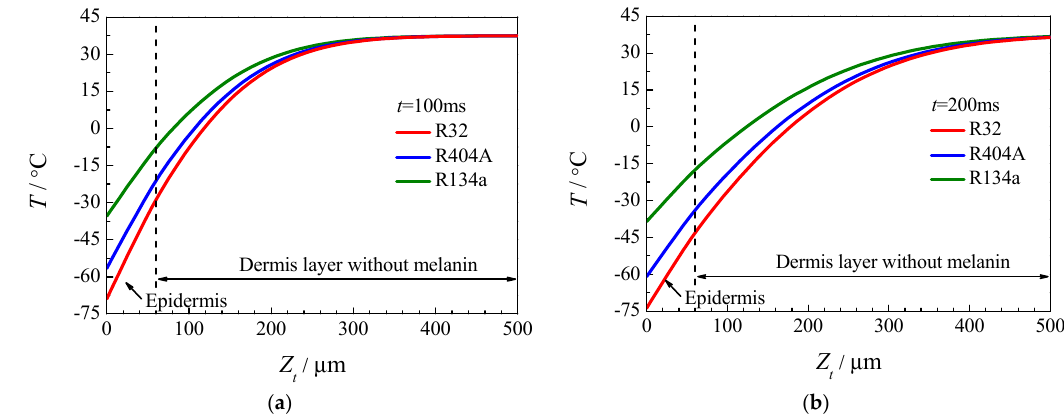
Figure 16. Comparison of axial temperature distribution inside skin tissue during CSC with three cryogens under optimum spray distance: ( a ) t = 100 ms and ( b ) t = 200 ms.